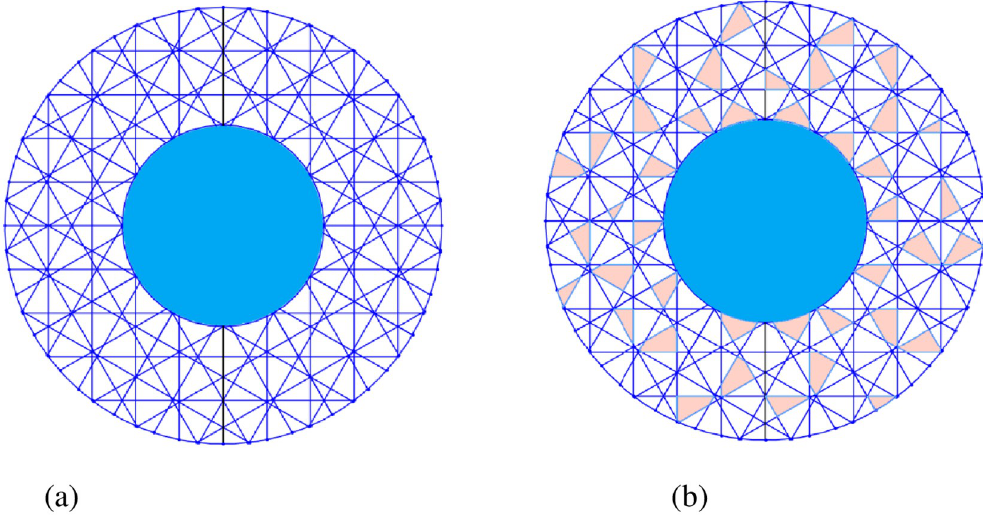
Fig 3. Schematic diagram of pit membrane of the TPS. (a) Pit membrane structure. (b) porosity distribution.